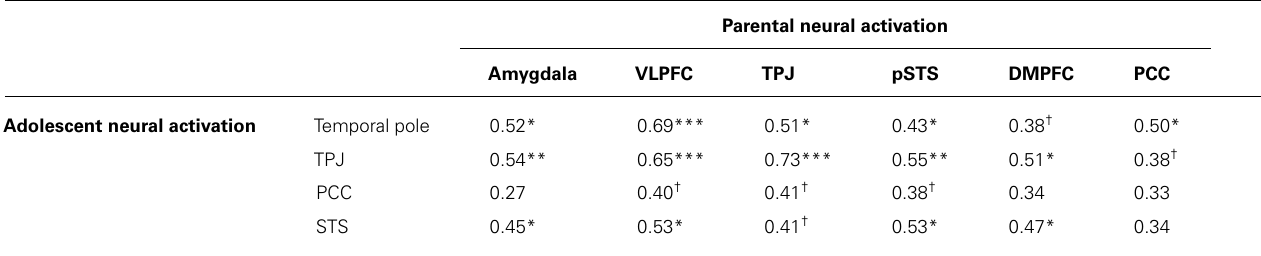
Table 5 | Correlations between parent and adolescent neural responses in regions that correlated with adolescent emotional competence during affect labeling versus